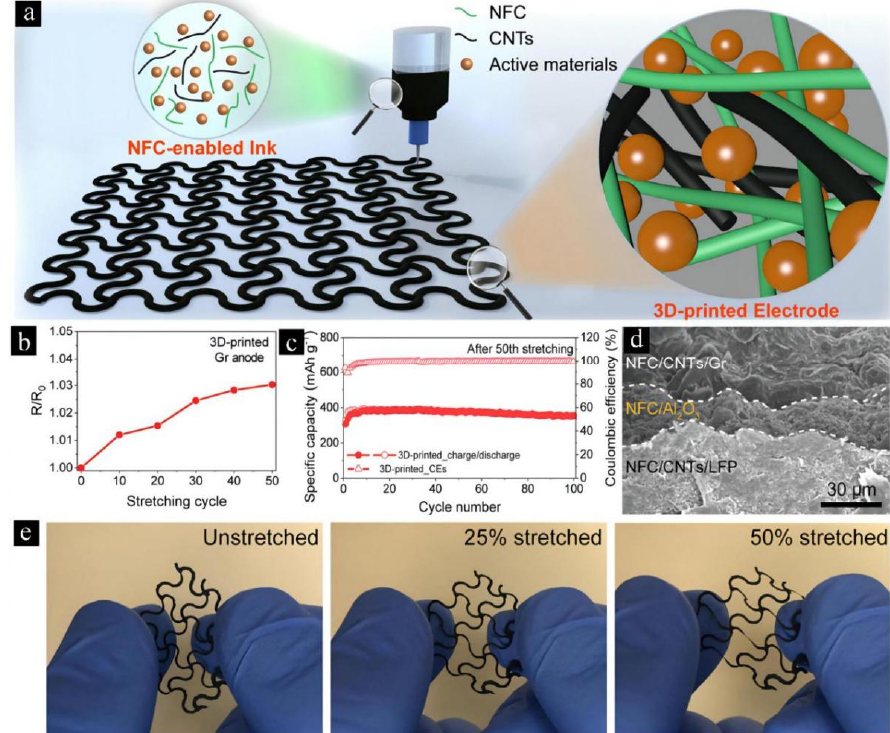
Figure 9. ( a ) Composition and morphology of the ink for 3D printing. ( b ) Normalized resistance after different cycles. ( c ) Cycling stability of the electrode after 50th stretching. ( d ) SEM image of cross-section for the electrodes and separator. ( e ) Images of the electrode in different stretched states. Reprinted with permission from [102]. Copyright Elsevier Publisher,